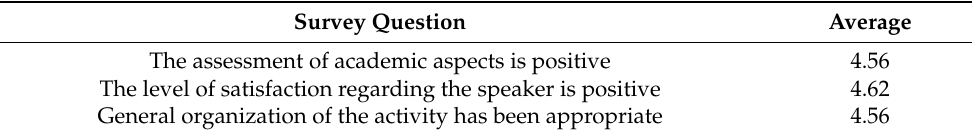
Table 4. Teachers’ surveys